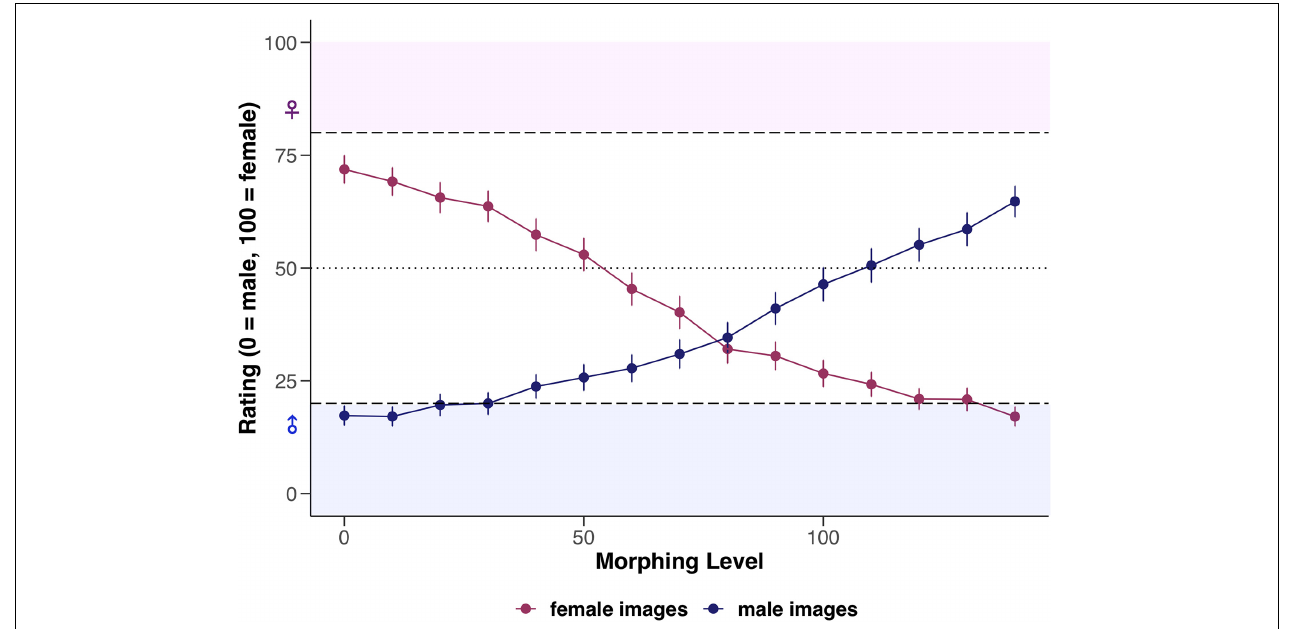
FIGURE 2 | Mean ratings of female and male images depending on morphing level (0–140), visualized separately for female and male participants. Error bars represent standard error (SE). Dashed horizontal lines represent the a priori defined cut-off values (ratings between 0 and 20 = unambiguously male, ratings between 80 and 100 = unambiguously female, and ratings of 50 =